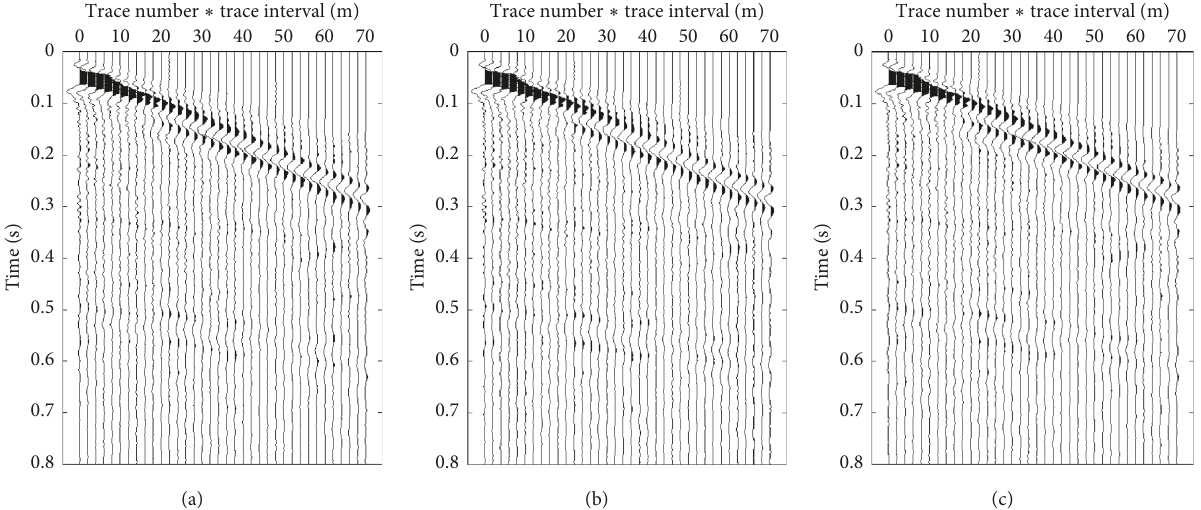
Figure 8: Time-history profile corresponding to Ux measuring line of the earth-rock dam crest with different hazard Poisson’s ratios. (a) μ 0. (b) μ 0.1. (c) μ 0.45. (cid:31) (cid:31)